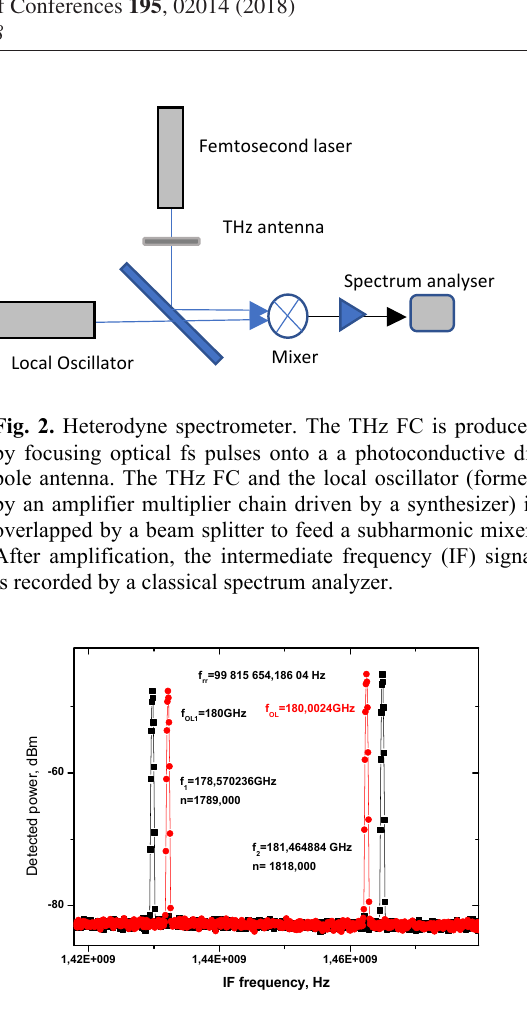
Fig. 3. High resolution spectra of the THZ FC obtained by use of heterodyne detection in which each component is clearly identified by an integer corresponding to an exact harmonic of the repetition